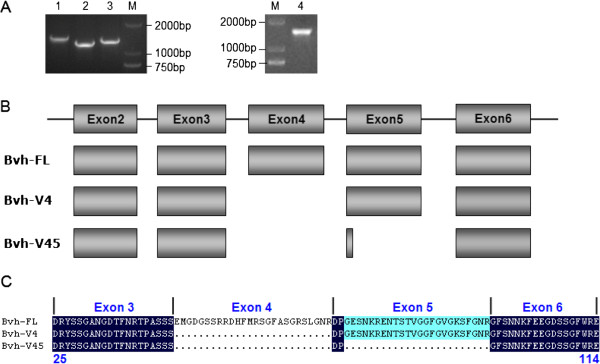
Alternative splice of Bvh in bovine testes. A. Agarose gel electropherograms of the splice variants from testis tissues developed by RT-PCR. Line 1-3 were amplification fragment of primer 1, line1 was full-length transcript, and line 2-3 were splice variants. Line 4 was amplification fragment of primer 2. Molecular marker was DL2000. B. Splice variants in coding region of Bvh. Number labelled boxes indicate the genomic regions identical to cDNA (exon2 to 6). FL means the full-length transcript, V4 is splice variant lack of exon4 and V45 is splice variant lack of exon4 and 5. C. Amino acids changes caused by alternative splicing. The alignment figures display the changes at the protein level of two identified splice variants compared to full-length protein.